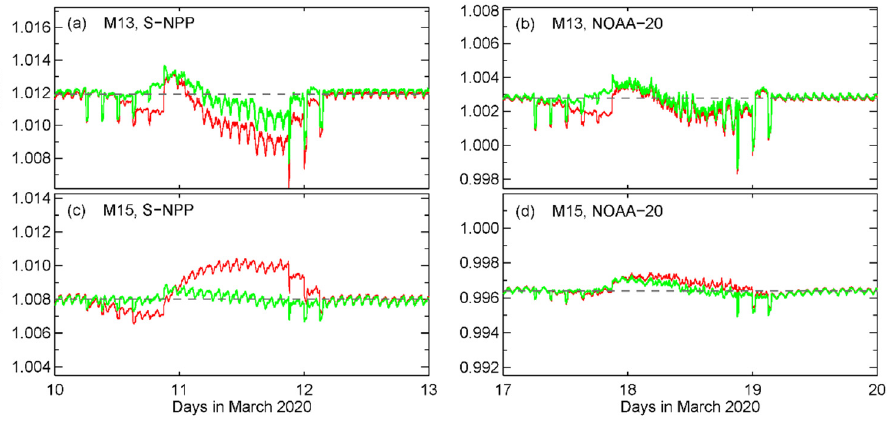
Figure 6. F-factor time series during the March 2020 WUCD events: ( a ) S-NPP M13, ( b ) NOAA-20 M13, ( c ) S-NPP M15, and ( d ) NOAA-20 M15. F-factors without WUCD bias correction are shown in red color, and F-factors with WUCD bias correction (applied in the operational processing) are shown in green color.